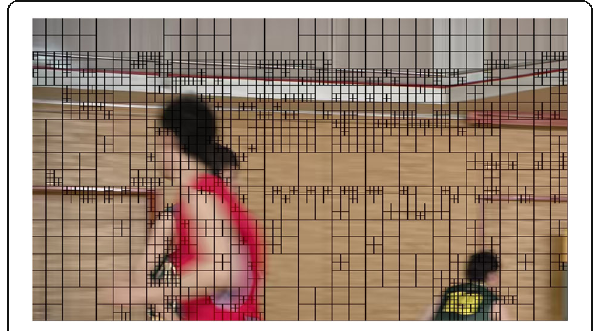
Fig. 3 The optimal CUs of